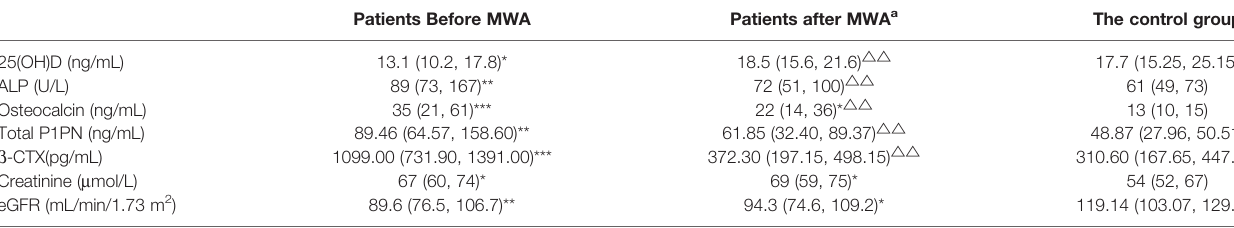
TABLE 4 | Differences in bone metabolic pro fi les and renal function between PHPT patients and controls. Patients Before MWA Patients after MWA a The control